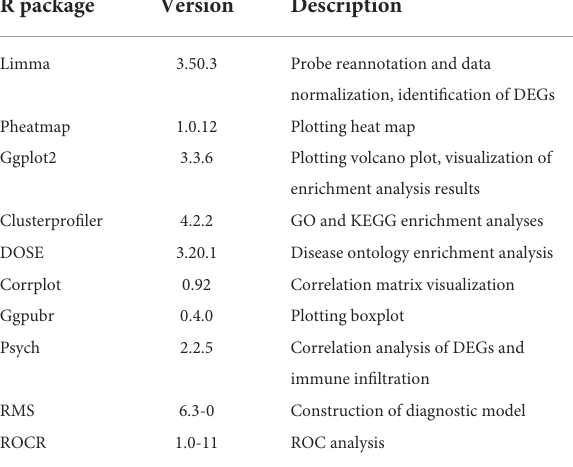
TABLE 2 R packages for bioinformatics